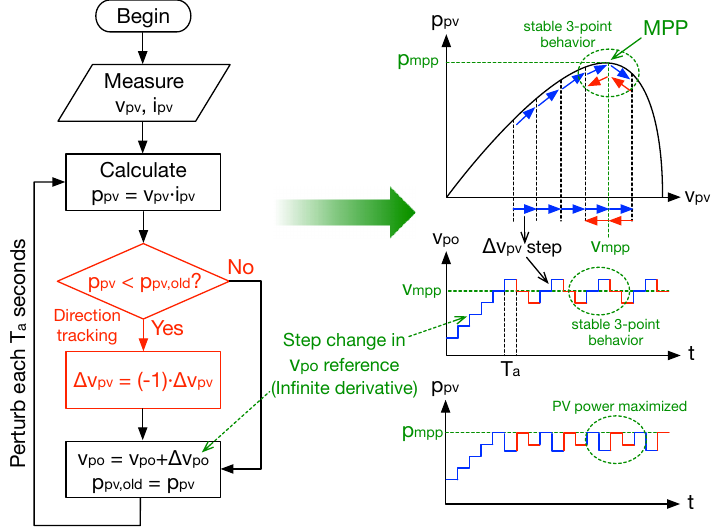
Figure 2. P&O algorithm: flowchart, behavior, and waveforms.